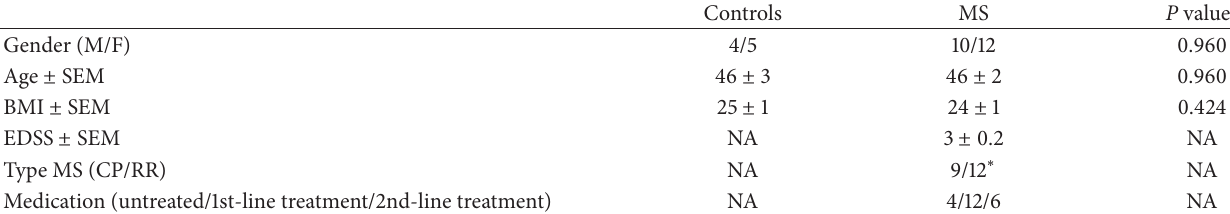
Table 1: Clinical details of the study